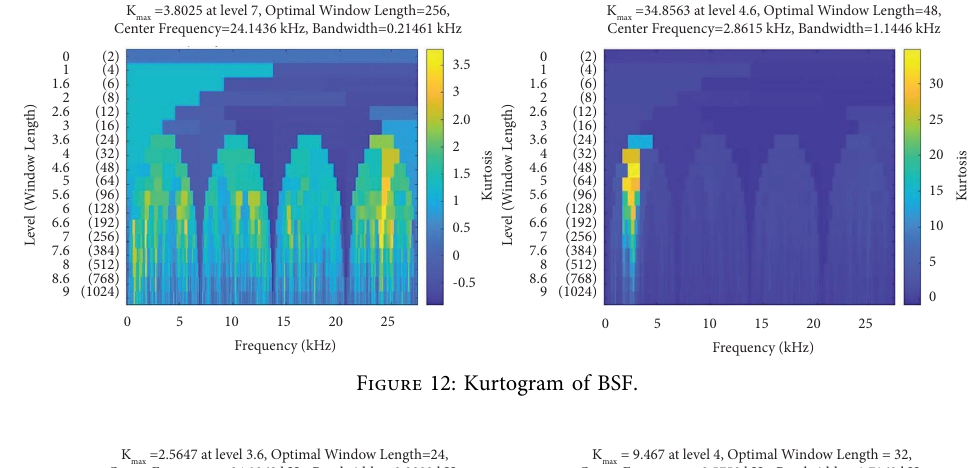
Figure 12: Kurtogram of BSF.